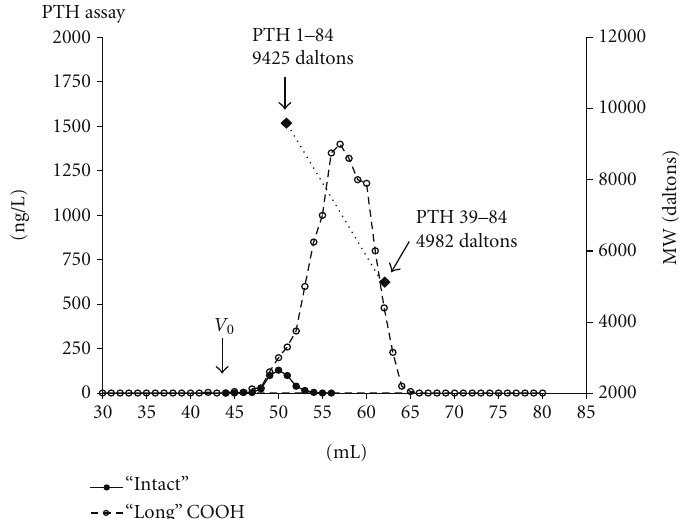
Figure 1: Elution profile of a serum sample from a patient with end-stage renal disease loaded on a Hiload Superdex 30 1.6 × 60 column. PTH was measured using a carboxyl terminal assay (“long” COOH) and a routine “intact” PTH